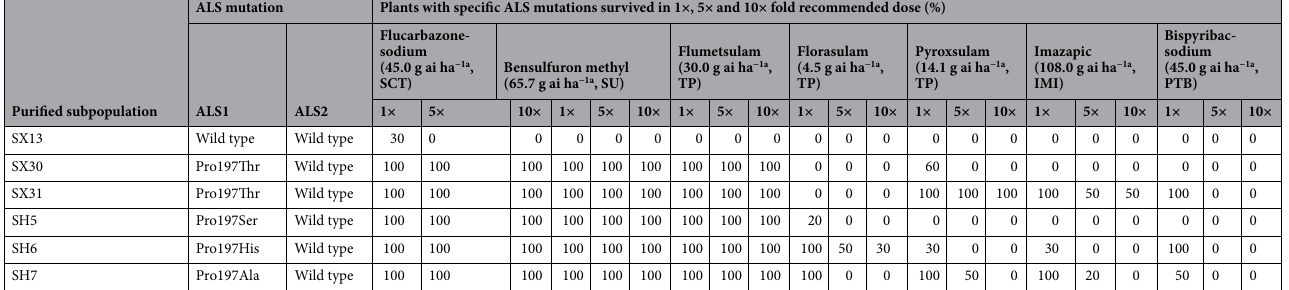
Table 1. The cross-resistance to other ALS-inhibition herbicides of the high resistant subpopulations of D. sophia . SCT sulfonylamino-carbonyl-triazolinones, SU sulfonylurea, TP triazolopyrimidine, IMI imidazolinone, PTB pyrimidinyl-thiobenzoate. a The onefold discriminating-dose known to control the S population.